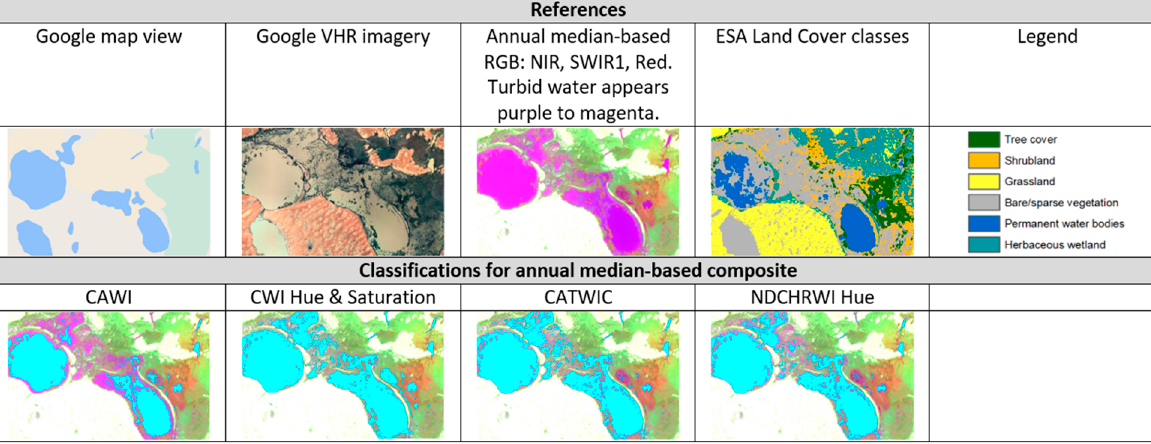
Figure 7. Index performance comparison in an arid wetland area. Location: North of Narriearra Caryapundy Swamp National Park, Queensland, Australia (151.3054, − 27.558). Reference RGB: NIR, SWIR1, Red, min: 0, max: 0.3.